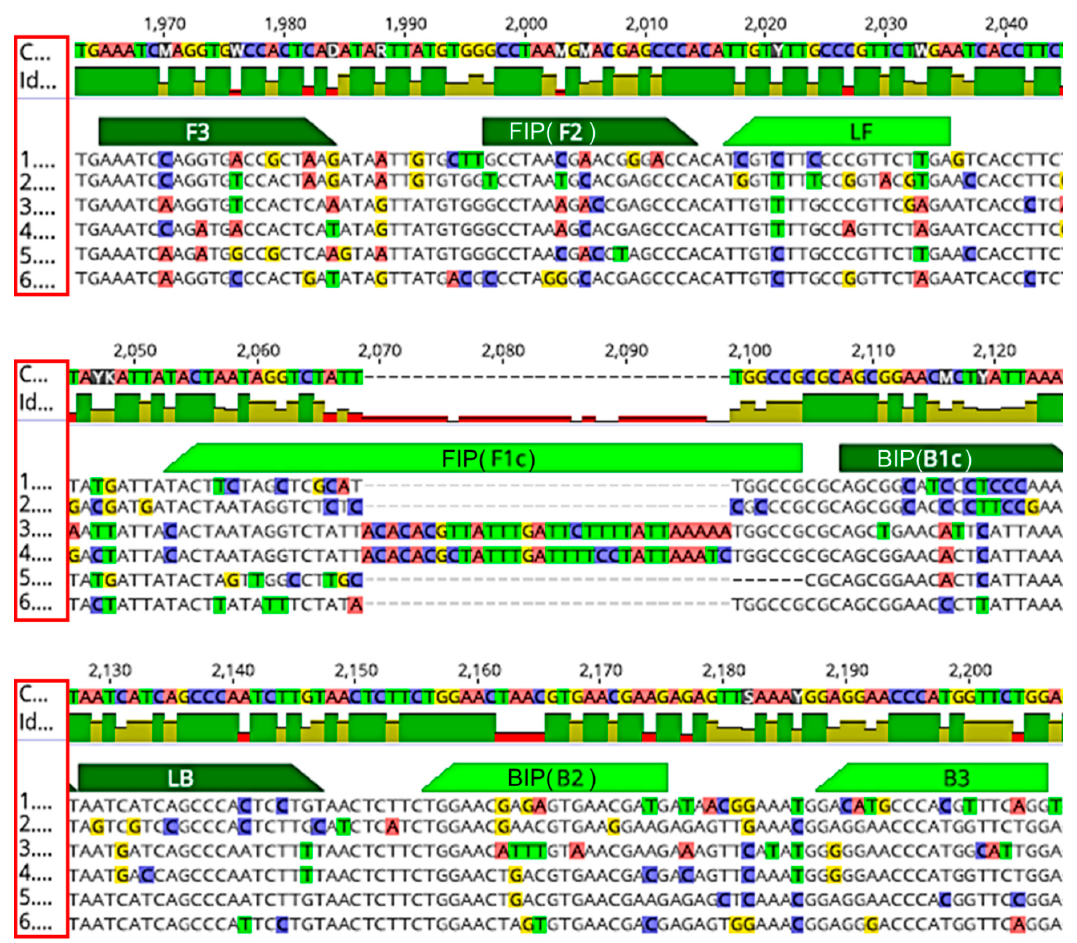
Figure 8. The s pecificity of six LAMP primers (F3, B3, FIP [F1c-F2], and BIP [B1c-B2]) to bind to the CuLCrV-specific gene sequence (DNA-A). An alignment shows single-nucleotide polymorphisms (SNPs), insertion and deletion mutations (colored letters) for CuLCrV LAMP primer binding sites to other begomoviruses. The red box is showing the numbers for the virus sequences, where 1: CuLCrV, 2: BCMV, 3: MCLCV, 4: SYMMV, 5: SLCV and 6: SMLCV. Di ff erent colors within nucleotides are showing SNPs and insertion / deletion mutations among